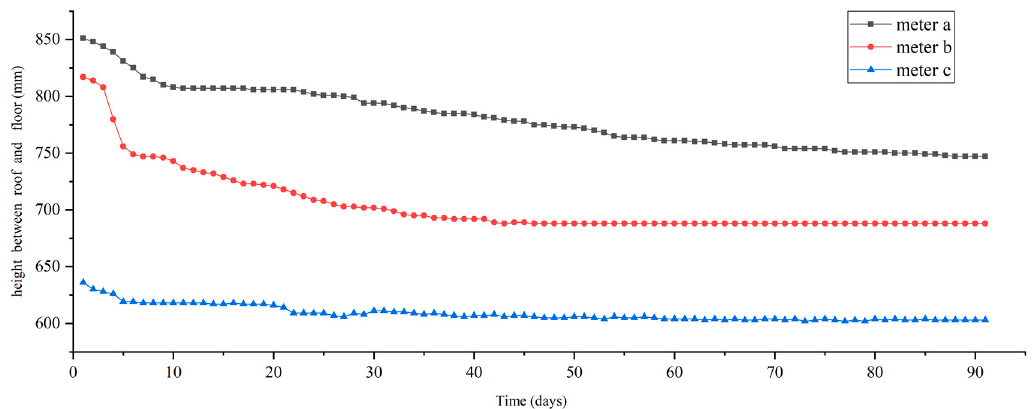
Figure 12. Variation of displacement in meter a.